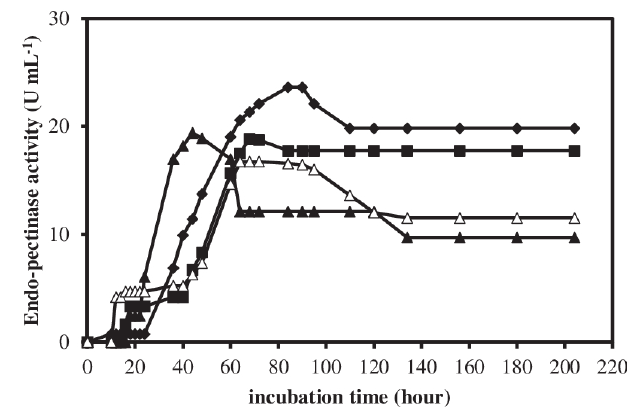
Fig. 5 – Effect of different CaCl do-pectinase production by Bacillus pumilus NRRL B-212 (pH= 8, T: 30 °C, agitation rate: 150 rpm, Cpectin: 1 % (w/v), calcium chloride concentrations; ■: 0.01 %, ♦: 0.02 %, ▲ : 0.04 %, ∆ : 0.00 %